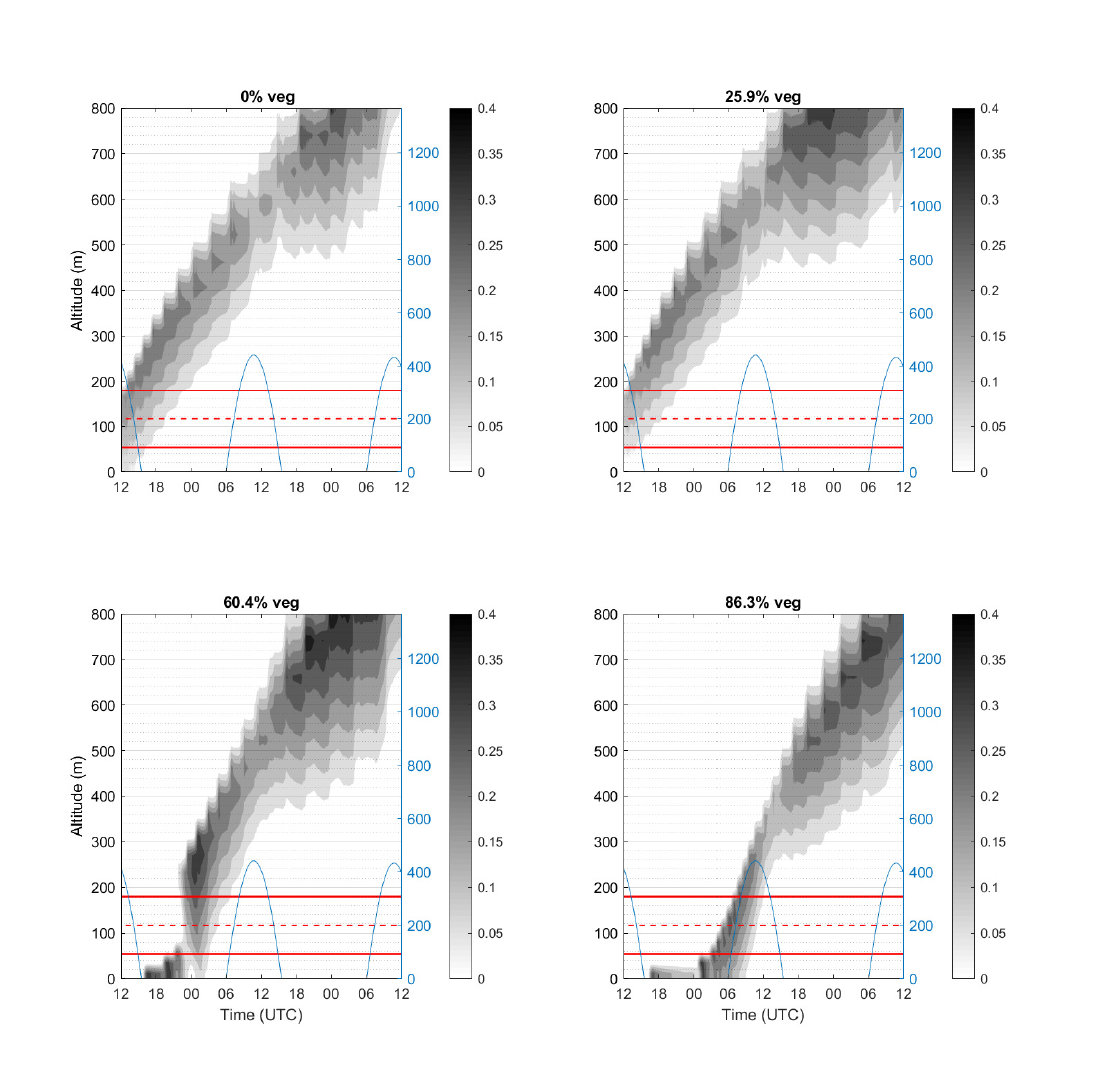
Figure 10. Time-height cross section of cloud water content (g/kg, filled contours) for the 18 October 2014 case for vegetation fractions of 0%, 25.9%, 60.4%, and 86.3%, respectively, using the Single Layer SBL scheme. Since the qualitative changes to the cloud evolution for each successive vegetation fraction in this case were roughly continuous, four vegetation fractions from bare ground to the reference case with the largest fraction of vegetation were shown here for illustrative purposes. Top of the atmosphere downwelling shortwave radiation (W/m 2 , right y -axis) has been added to indicate the diurnal cycle. The red lines indicate the elevation of a hypothetical wind turbine with a hub height of 117 m (dashed lines) and a rotor diameter of 126 m (solid lines indicating turbine